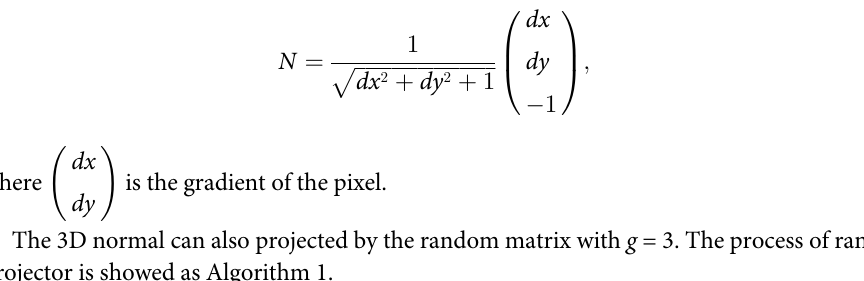
Algorithm 1: Random Projection Feature Input: Image I(x, y), the number of gradient components g , the projection dimension in a block k . Output: Random Project Feature F